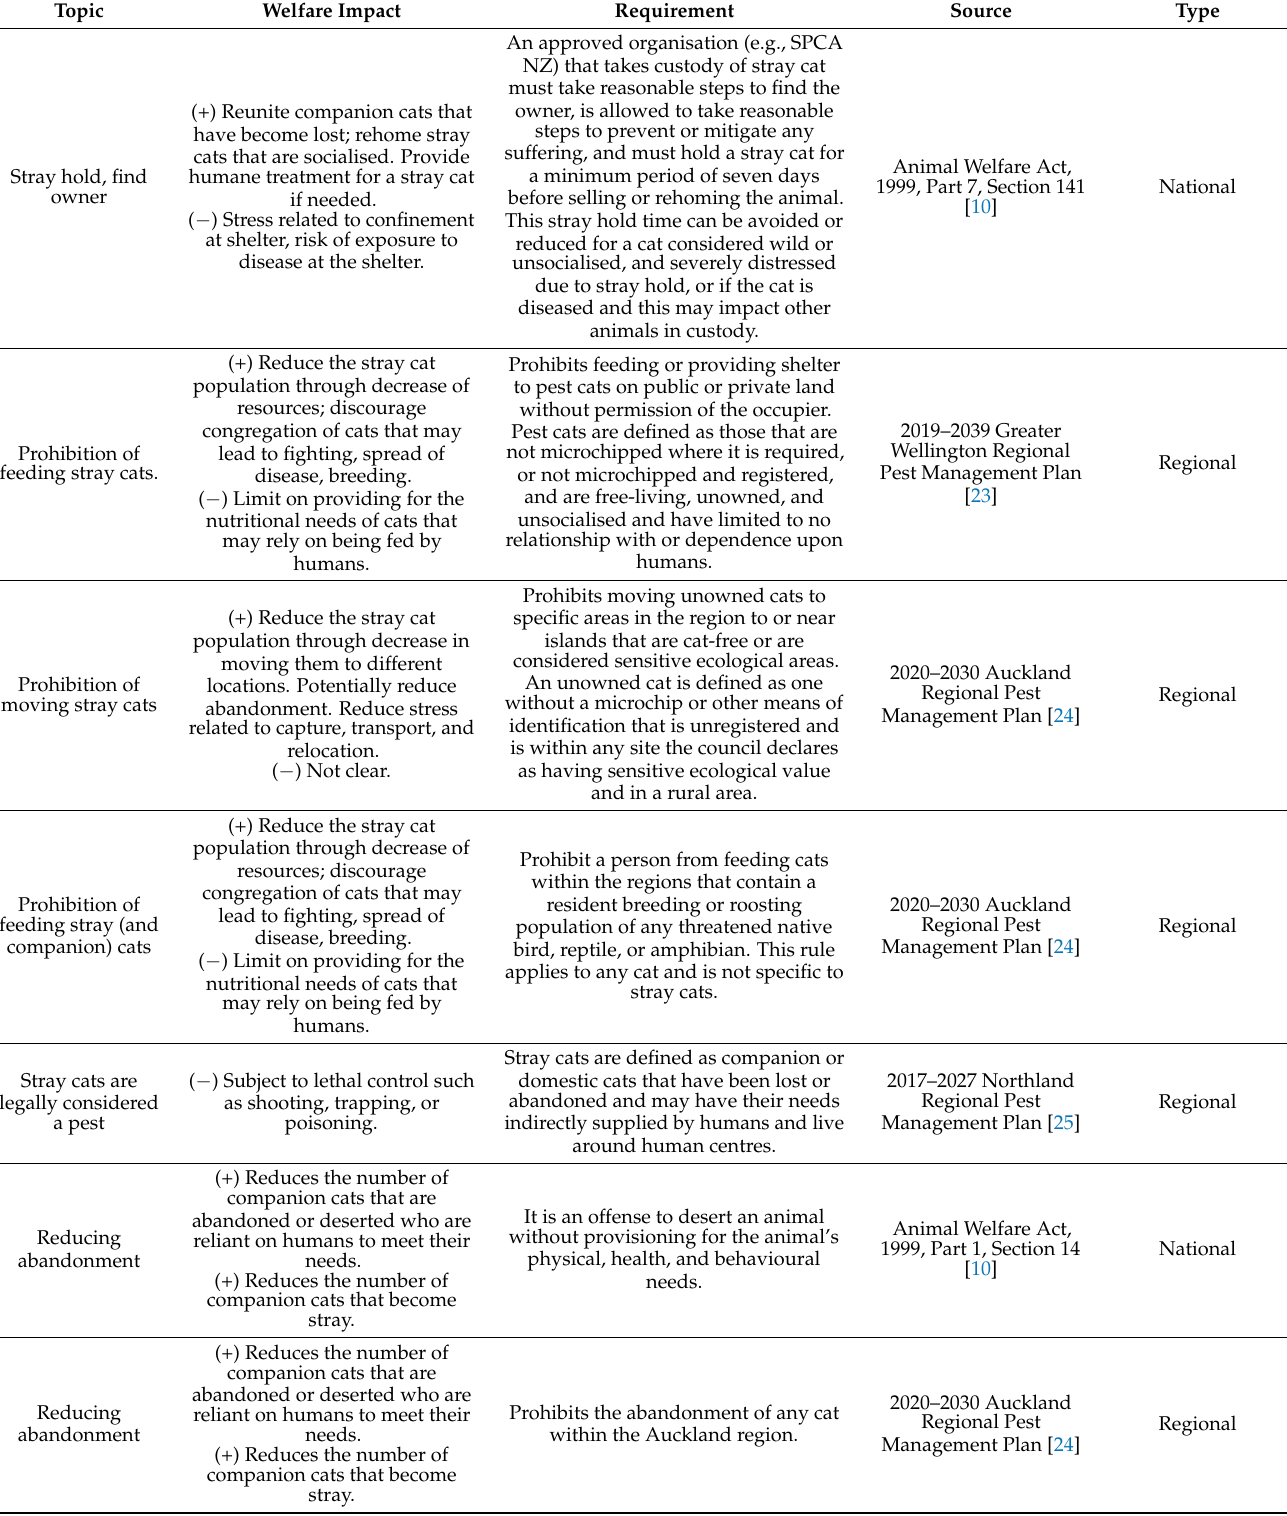
Table 1. Laws and regulations for controlling stray